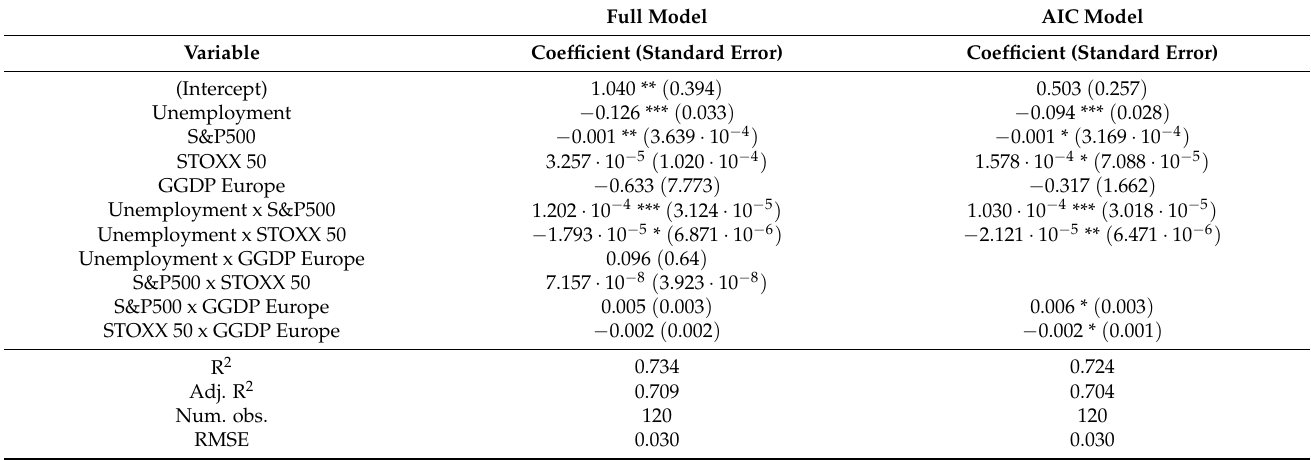
Table 6. Fitted linear regression model (7) with interactions before and after model selection.